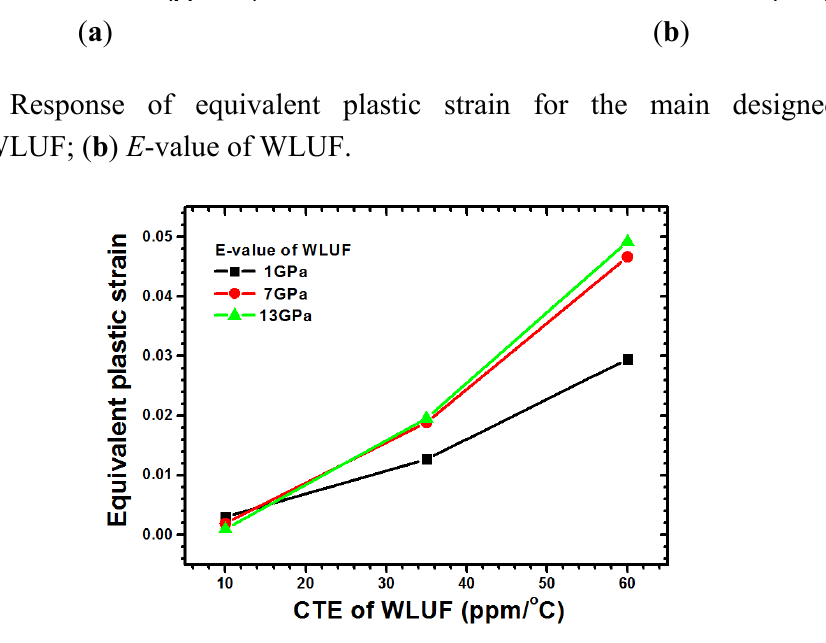
Figure 19. Interaction effect between CTE and E -value of WLUF on the equivalent plastic strain of lead-free solder equivalent plastic strain at the outermost